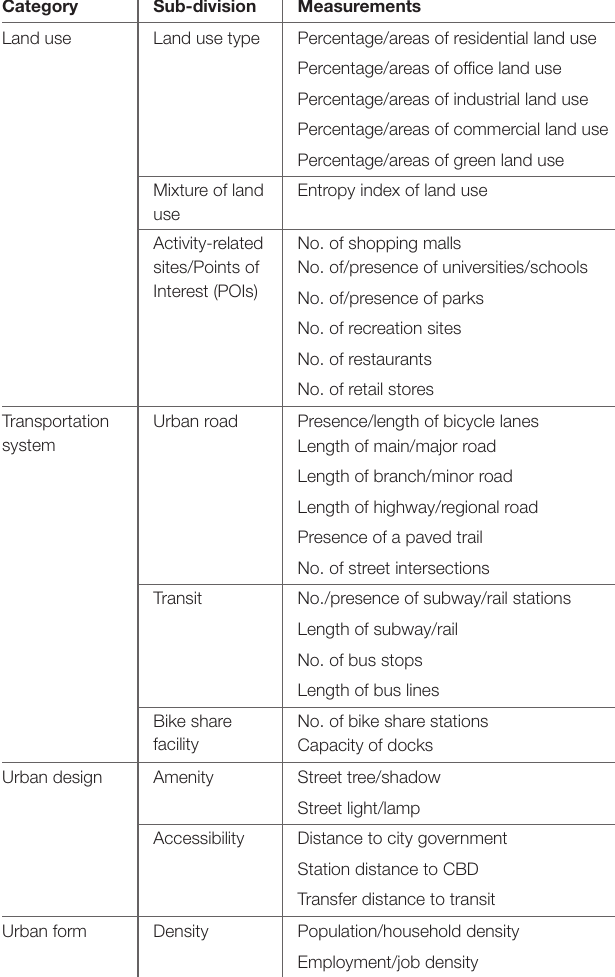
TABLE 1 | Categories and measurements of built environment features related to bike share usage.